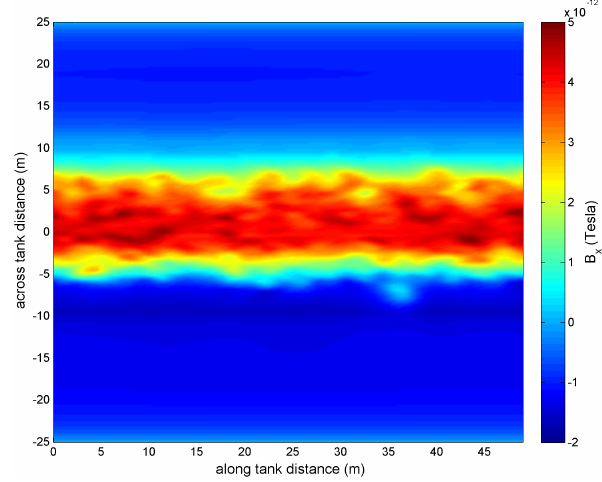
Figure 4. Top view of ship wake signature in the induced magnetic field for the case with ambient stratification at time t = 575. The x component of the induced magnetic field is shown at 1m below the